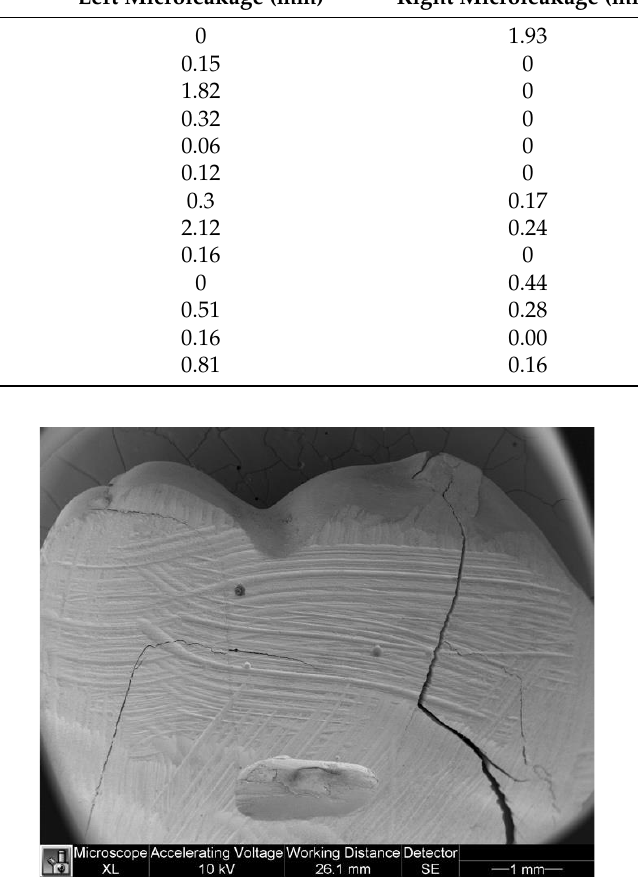
Figure 5. Microleakage in a specimen of study group.